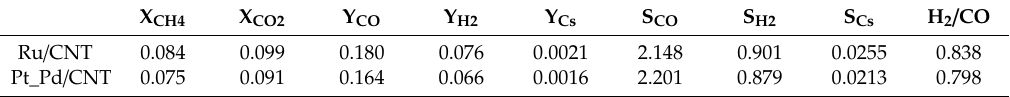
Table 6. Comparison of performances from Ru / CNT (model, this study) and Pt_Pd / CNT (model from [21]). T = 773K, P = 3.03 × 10 5 Pa, 0.001 kg catalyst, total feed 5.6 × 10 − 5 mole / s, feed CH 4 / CO 2 = 1. X CH4 X CO2 Y CO Y